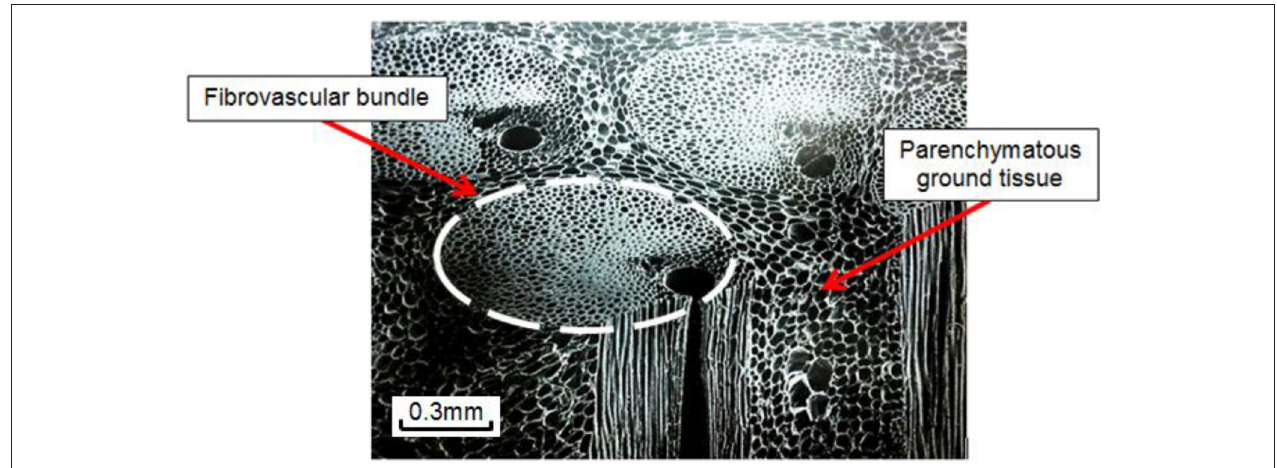
FIGURE 1 | Cocowood is a complex vascular tissue system that depicts a cellular structure that can be described as parallel stiff fibers embedded in foam. Its simple botanical description is a blend of two structurally and functionally divergent cell tissues: (a) the fibrovascular bundles with a honeycomb-like structure, which are rounded and dense groups of long fibers surrounding vessel elements for sap circulation, mainly orientated in the longitudinal axis of the stem, and (b) the ground tissue made up of foam-like polyhedral parenchyma cells.